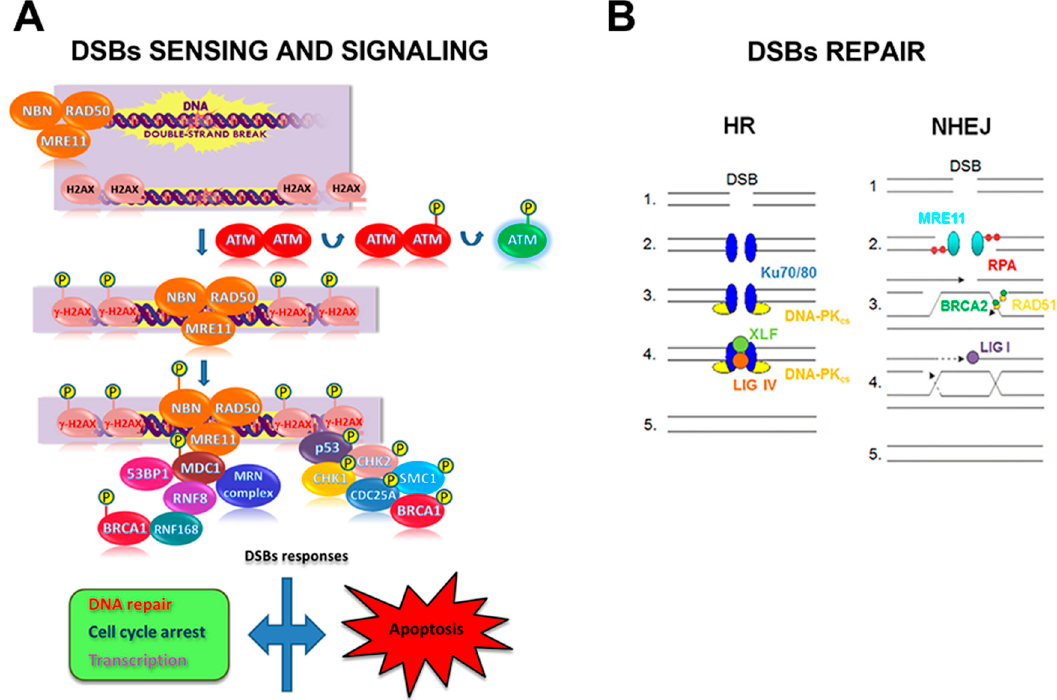
Figure 3. Double-strand break (DSB)s sensing, signaling and repair in mammalian